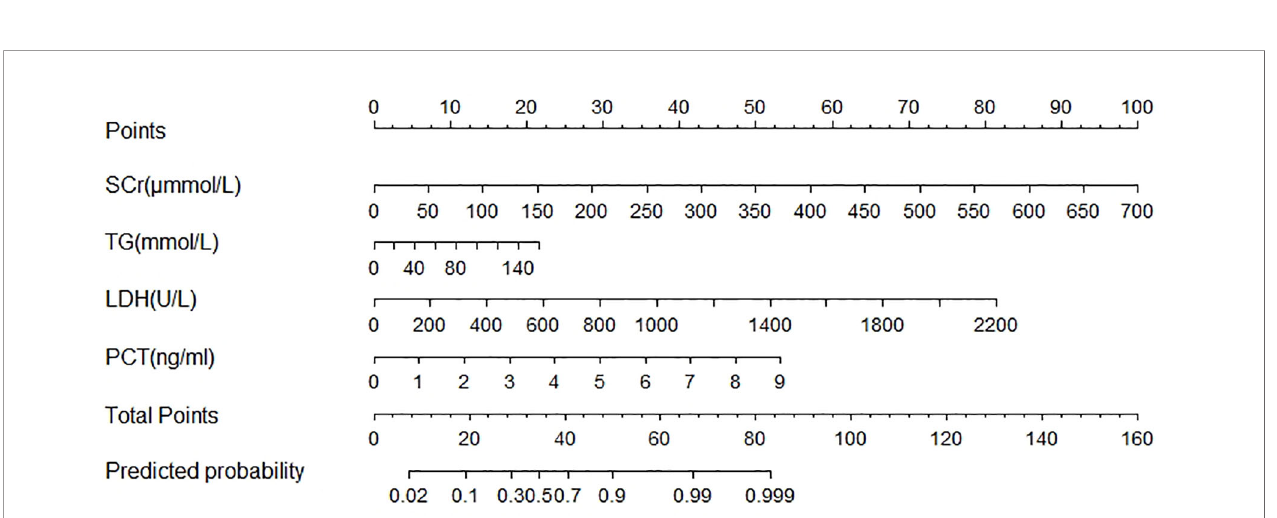
FIGURE 2 | Nomogram predicted the probability of Persistent Organ Failure in patients with acute pancreatitis during pregnancy. To estimate the probability of persistent organ failure, mark patient values at each axis, draw a straight line perpendicular to the point axis, and sum the points for all variables. Next, mark the sum on the total point axis and draw a straight line perpendicular to the probability axis. LDH, lactate dehydrogenase; PCT, procalcitonin; SCr, serum creatinine; TG,